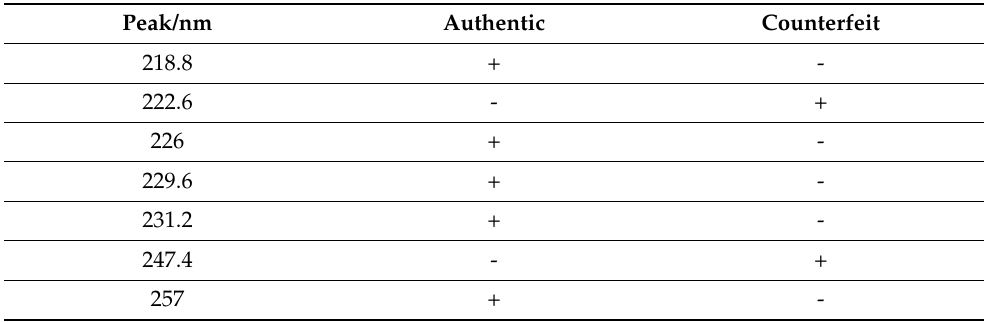
Figure 2. Comparing MEES spectra of counterfeit and authentic 20 Euro banknotes, at the same site (the lightly colored area in the frame). Table 1. List of main peaks which are missing in the authentic 20 Euro banknote and present in the counterfeit (and vice versa).